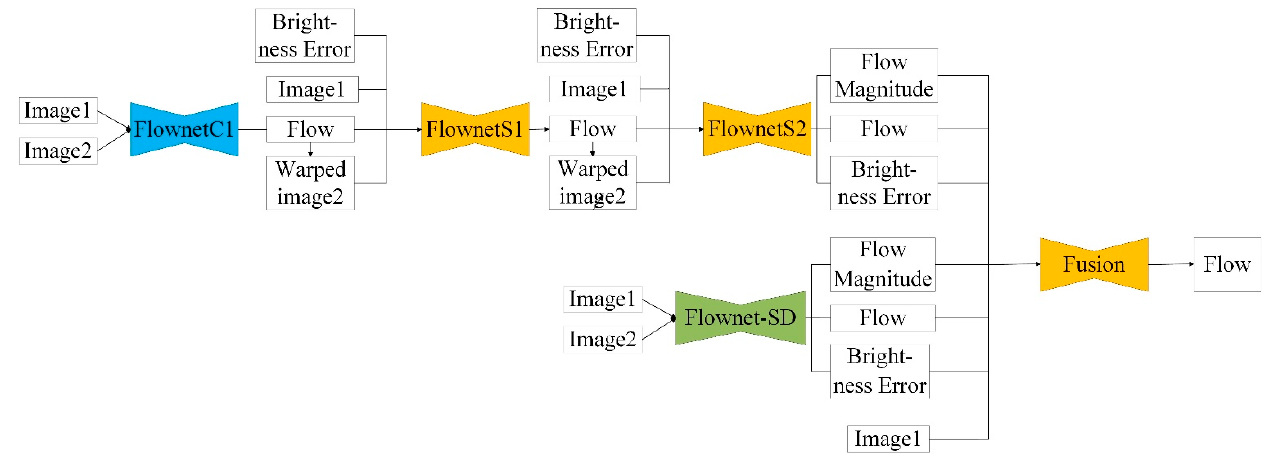
Figure 1. Schematic diagram of the Flownet2 network structure. Table 1. RMSE (pixel) of some DLOF methods on the Sintel data set. Table 1. RMSE (pixel) of some DLOF methods on the Sintel data set. Method